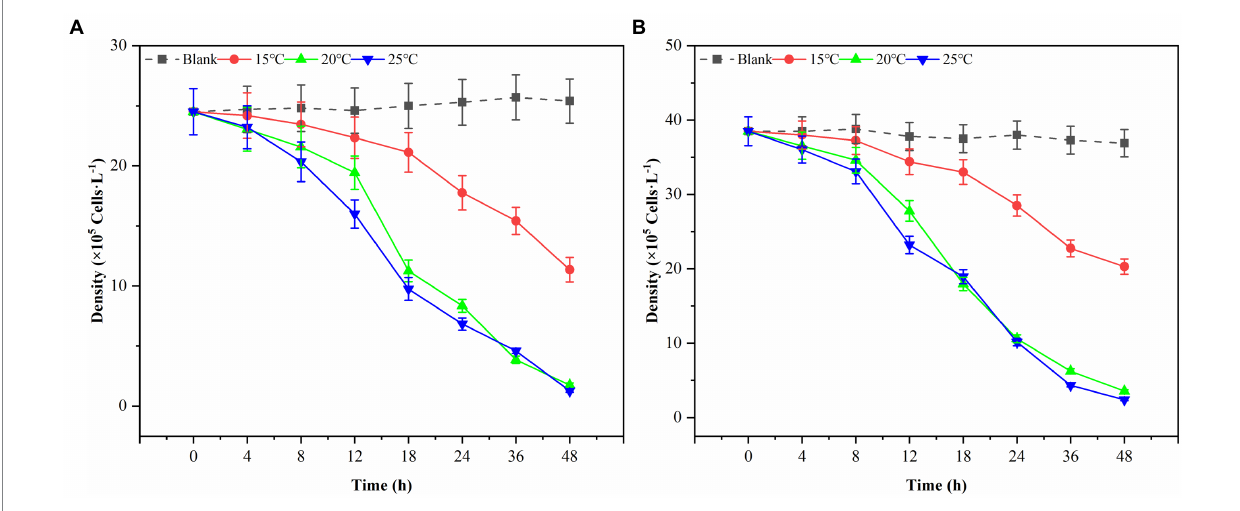
FIGURE 6 The changes of algal density of G. catenatum (A) and K. mikimotoi (B) with time were observed by the addition of Ps3 solution at different temperatures.